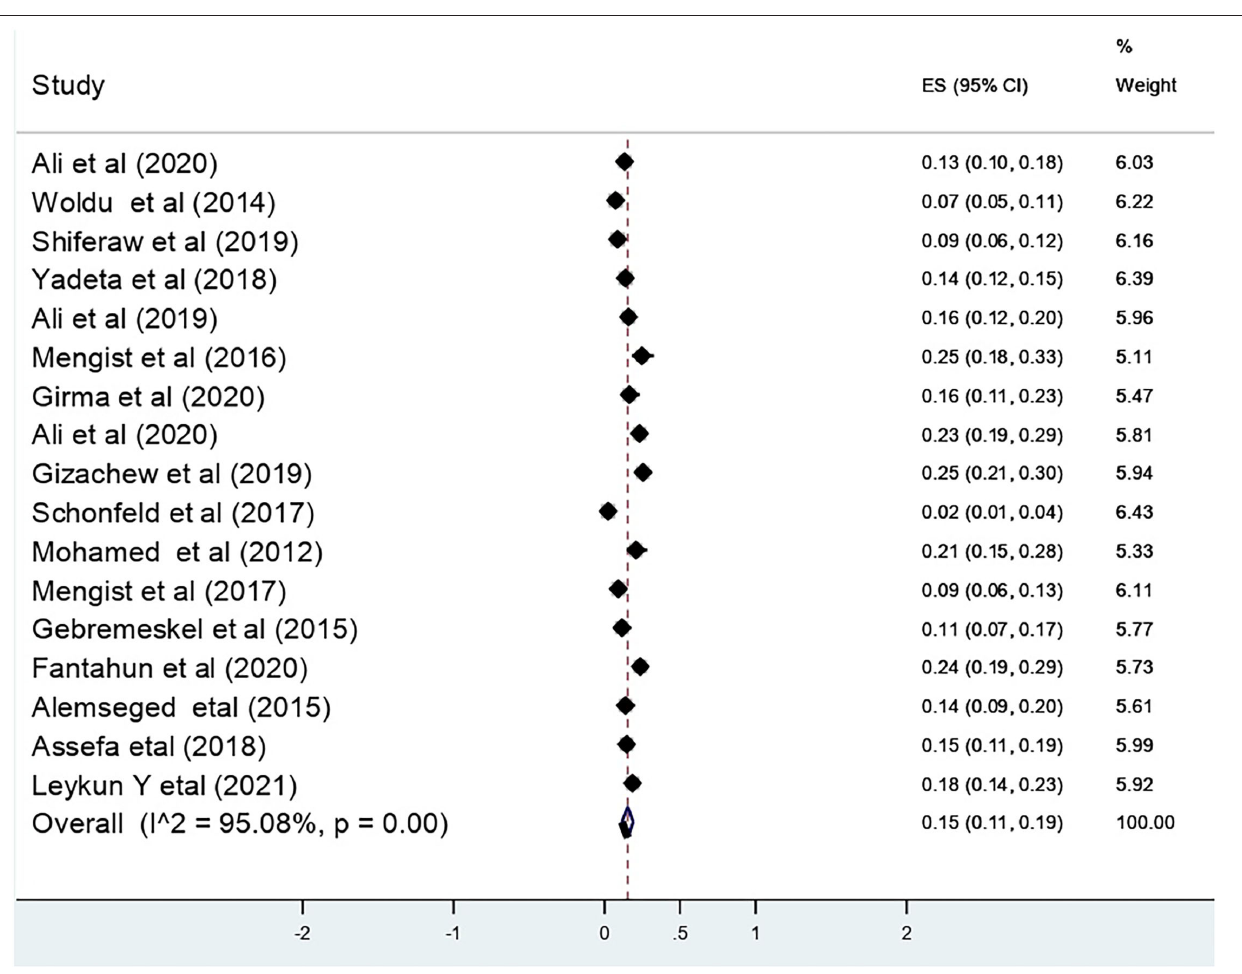
FIGURE 2 | Recto vaginal colonization of GBS among pregnant women in Ethiopia 2022.